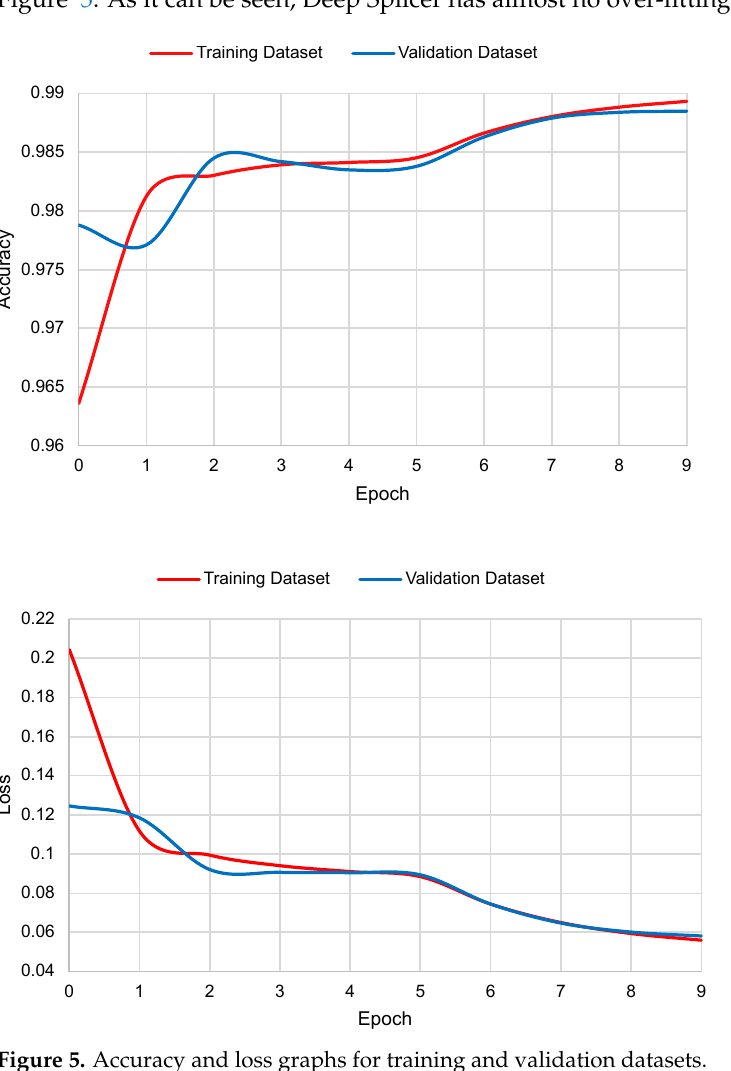
ranges between 0.52% and 1.21%. The model has no problem differentiating between